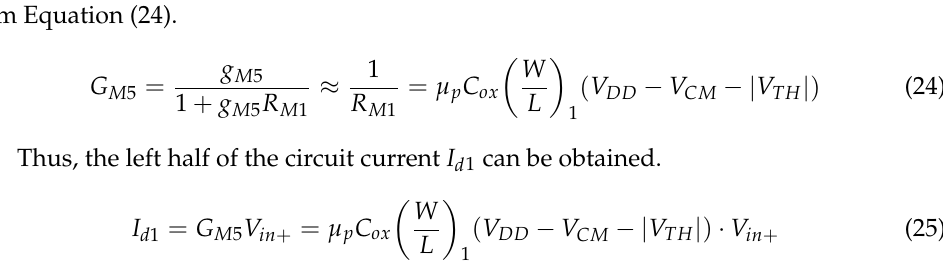
Figure 13. The transistor-level circuit structure diagram of nonlinear multiplier.